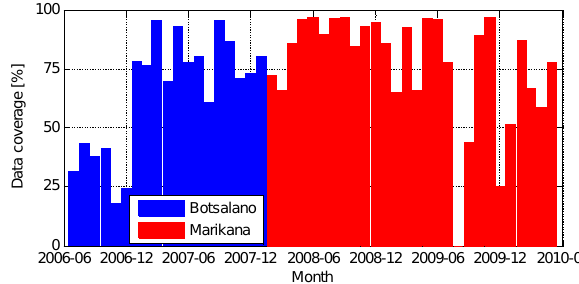
Fig. 2. DMPS data